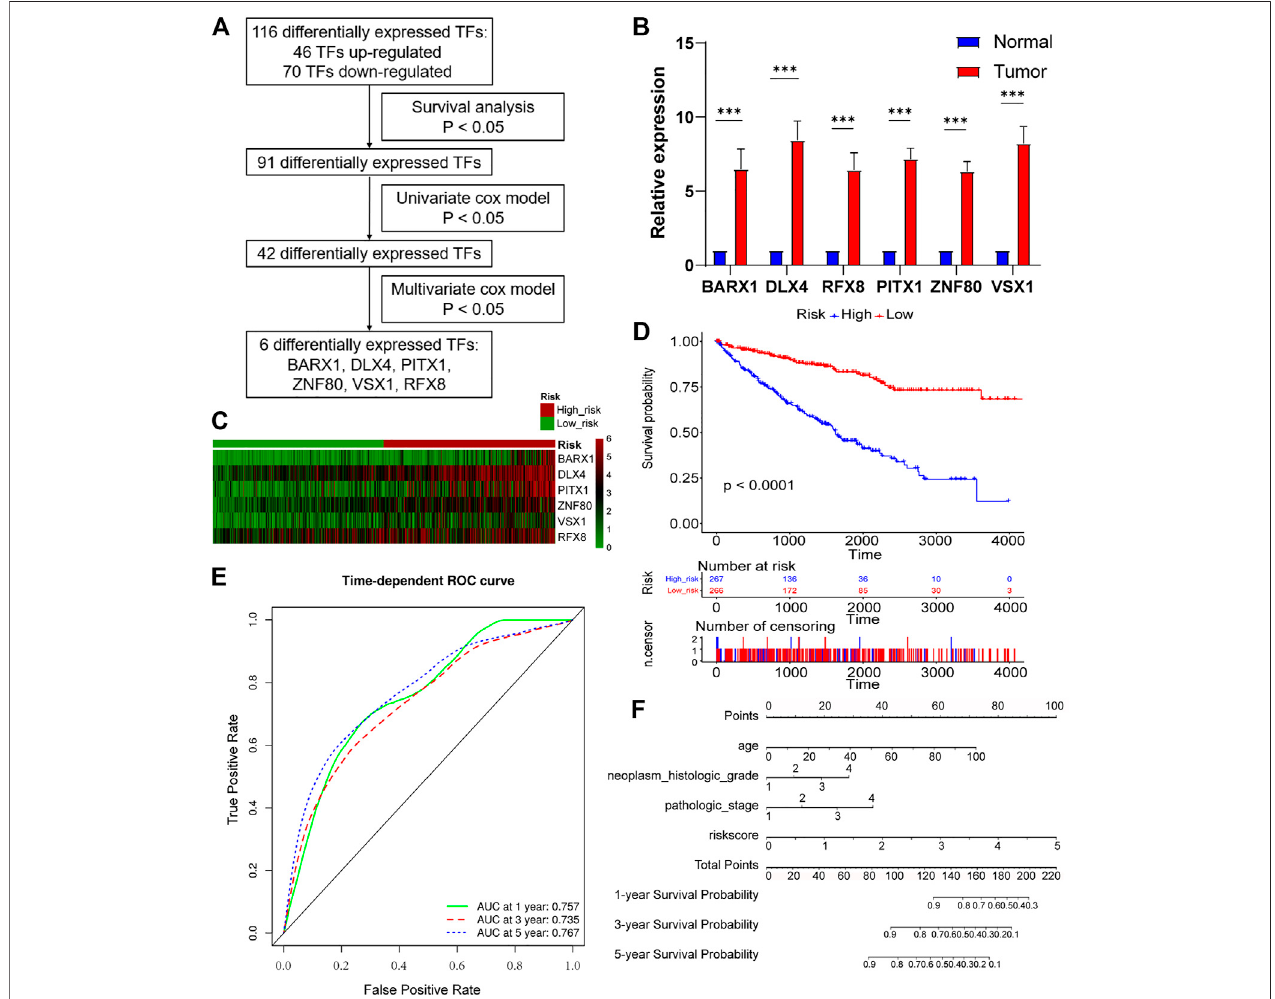
FIGURE 4 | Six-TF – based panel as a prognostic model for OS in ccRCC. (A) The process to identify TF genes that signi fi cantly correlated to OS. (B) Real-time polymerase chain reaction (RT-PCR) is performed in 16 paired tumor and matched adjacent normal tissues. BARX1, DLX4, PITX1, ZNF80, VSX1, and RFX8 are upregulated in tumor tissues. (C) Patients in the TCGA KIRC cohort were divided into high-risk group and low-risk group. Expression pro fi le of 6 TFs (BARX1, DLX4, PITX1,ZNF80,VSX1,andRFX8)inhigh-riskandlow-riskpatientsisshown. (D) TheKaplan – MeierplotshowstheOSinhigh-riskandlow-riskpatientsintheTCGA KIRCcohort. (E) Time-dependentareaunderthereceiveroperatingcharacteristic(AUROC)curveisplottedtoevaluatetheprognosticvalueofthe6-TFgeneprognostic signature for OS. The area under the curve (AUC) at one, three, and fi ve years is0.757, 0.735, and 0.767, respectively. (F) The prognostic nomogram of the 6-TF model for OS at 1, 3, and 5 years.